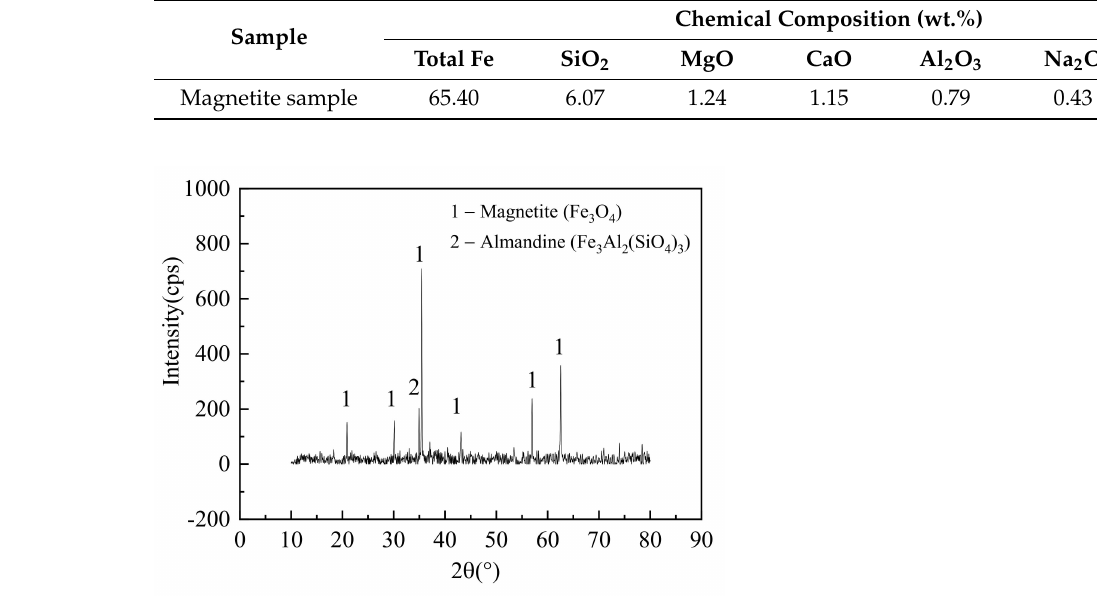
Figure 2. XRD spectrum of the raw iron ore sample.